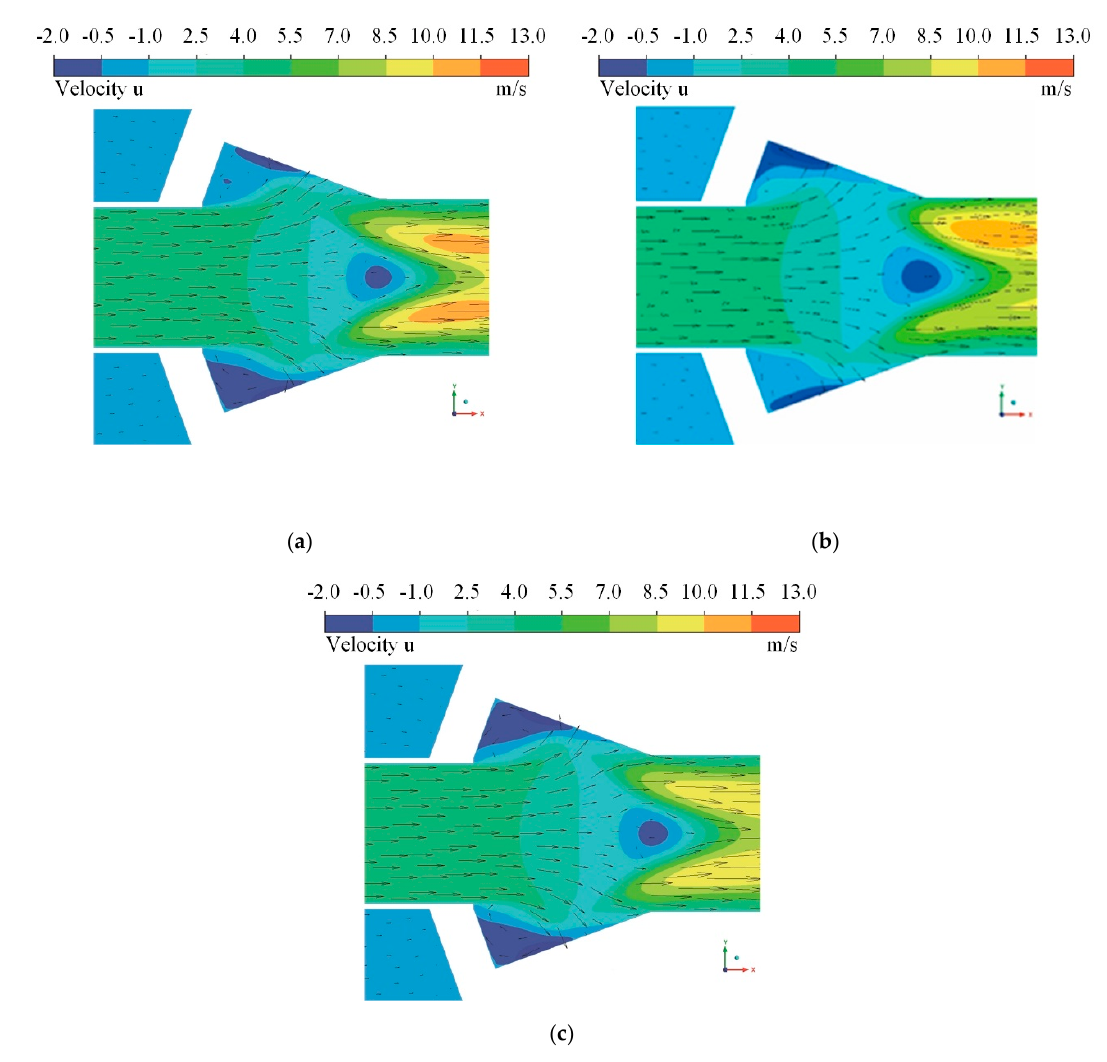
Figure 6. The velocity cloud and vector charts of square, circular and triangle nozzles. ( a ) Square nozzle; ( b ) Circular nozzle; ( c ) Triangle nozzle.